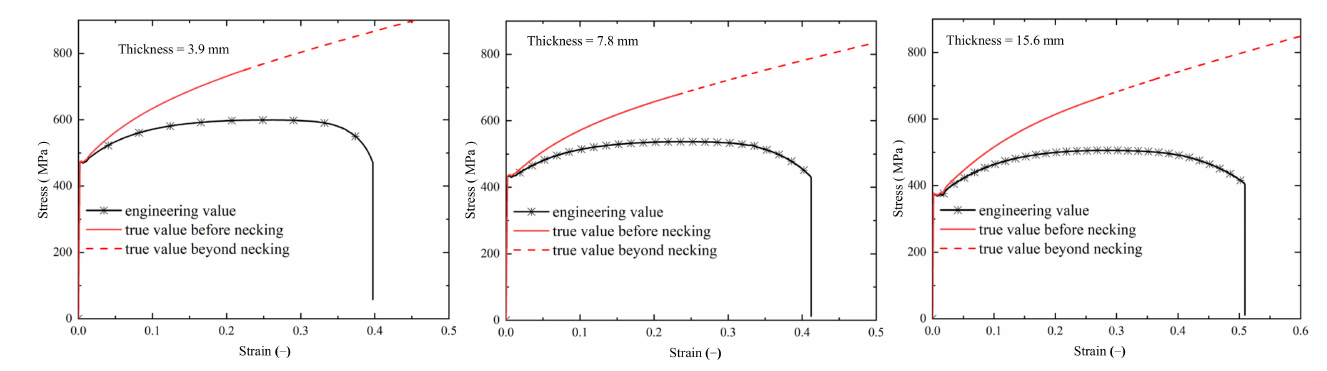
Figure 7. Stress-strain curves of the plates.